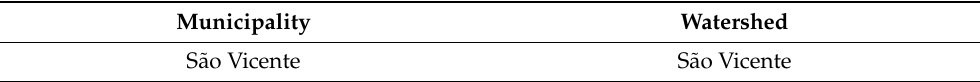
Table 11. Watersheds with high flood risk. (Source: